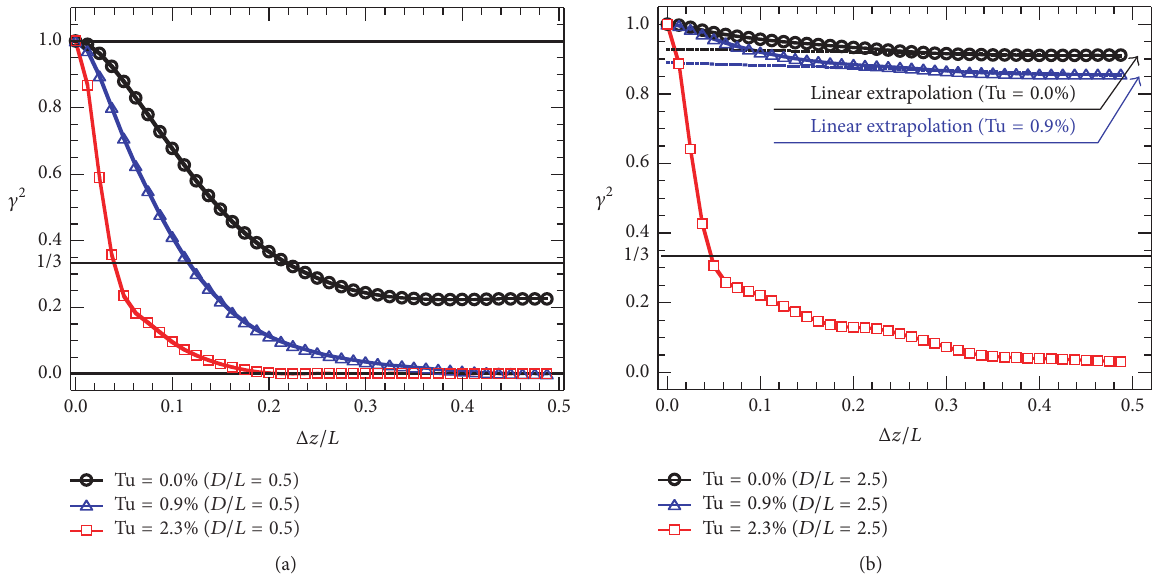
Figure 23: Coherence of velocity V /𝑈 ∞ at fundamental frequency in spanwise direction ( 𝑥/𝐿 = 0.5 and y = 0). (a) Cavity flow without acoustic resonance ( 𝐷/𝐿 = 0.5). (b) Cavity flow with acoustic resonance ( 𝐷/𝐿 =